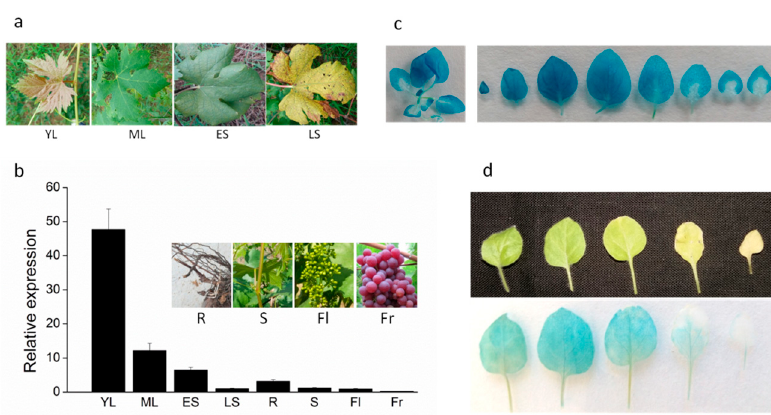
Figure 1. The expression of DRL1 during leaf senescence in grapevine. ( a ) Leaf senescence phenotypes in grapevine cultivar ‘Yatomi Rosa’. YL, expanding young leaf; ML, mature leaf that is fully expanded but with no visible yellowing; ES, early senescence leaf, with about 5% of the leaf area yellowing; LS, late senescence leaf, with more than 50% of the leaf area yellowing. ( b ) Relative expression of DRL1 during leaf senescence. The expression levels were determined using qPCR. The expression levels in LS leaves were set to 1. Bars represent mean ± standard deviation (SD). ( c , d ) GUS staining in leaves of P DRL1 -GUS transgenic tobacco plants at 10 d ( c ) and 20 d ( d ).